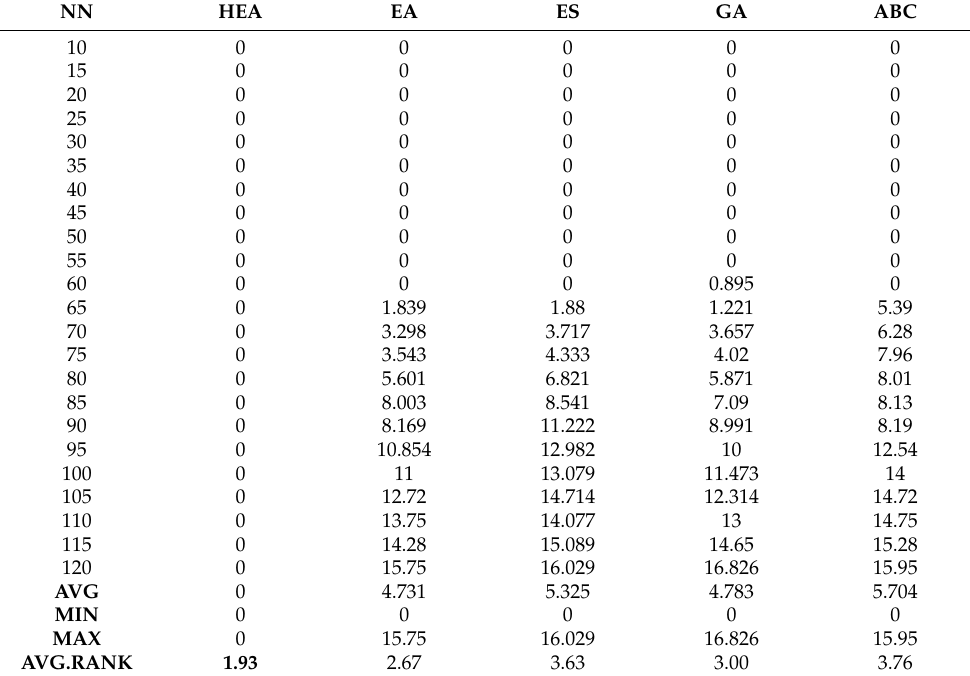
Figure 9. MAE-Energy values for different DHNN-RAN k SAT models. Figure 9. MAE -Energy values for different DHNN-RAN k SAT models. Table 9. Tabulated MAE -Energy values for different DHNN-RAN k SAT